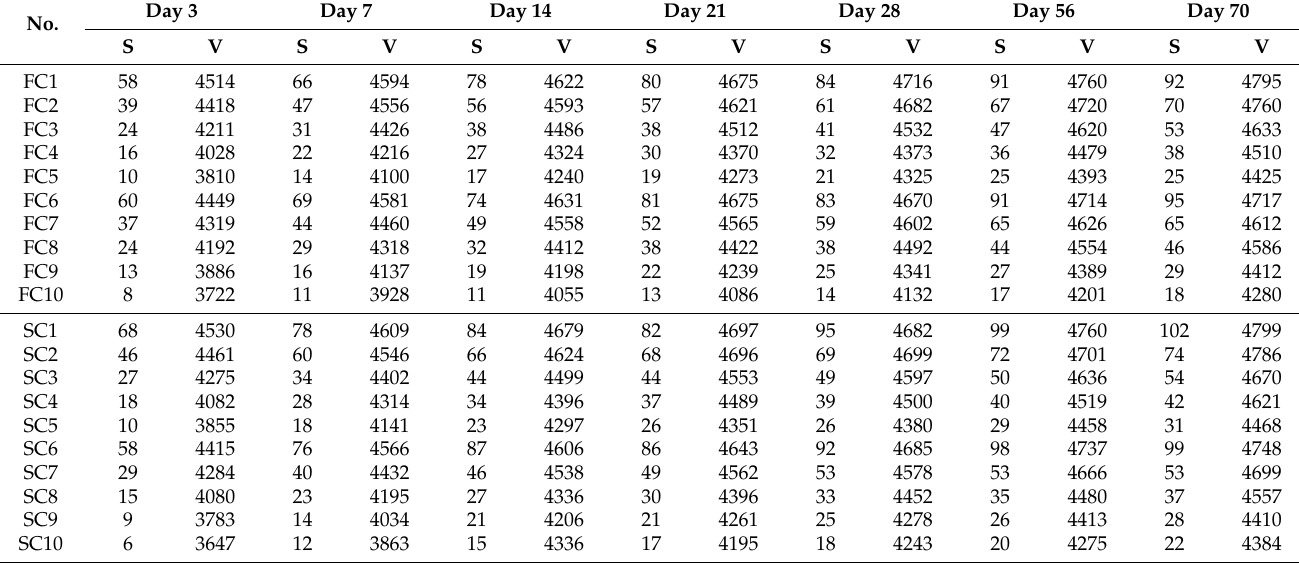
Table 6. The measured UPV and strength data for pozzolanic